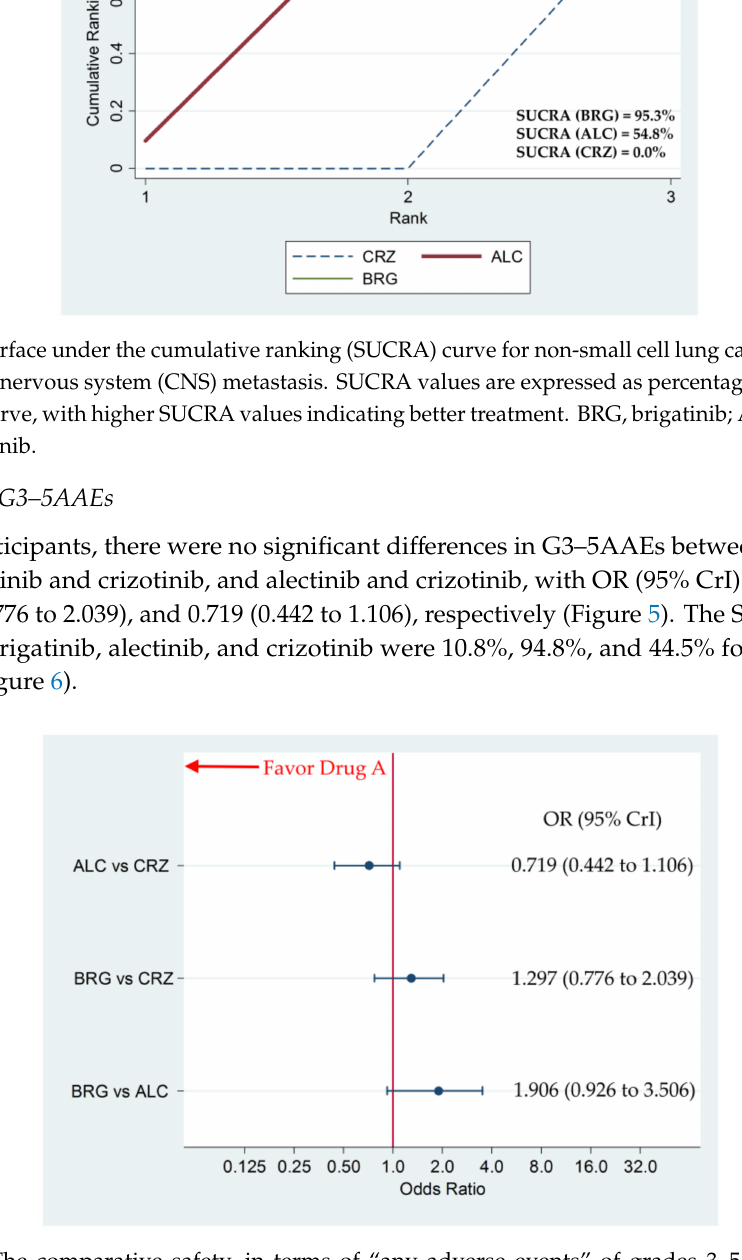
Figure 5. The comparative safety, in terms of “any adverse events” of grades 3–5 (G3–5AAEs), of brigatinib 180 mg once daily (7-day run-in period of 90 mg once daily) and alectinib 300 / 600 mg twice daily in all participants. The comparisons are expressed as drug A versus drug B. Data are expressed as odds ratio (OR) and 95% credible intervals (CrIs); ALC, alectinib; CRZ, crizotinib; BRG,